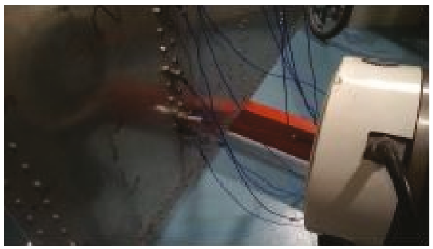
Figure 40: D2, 20 Hz excitation 1st superharmonic, reduced model.